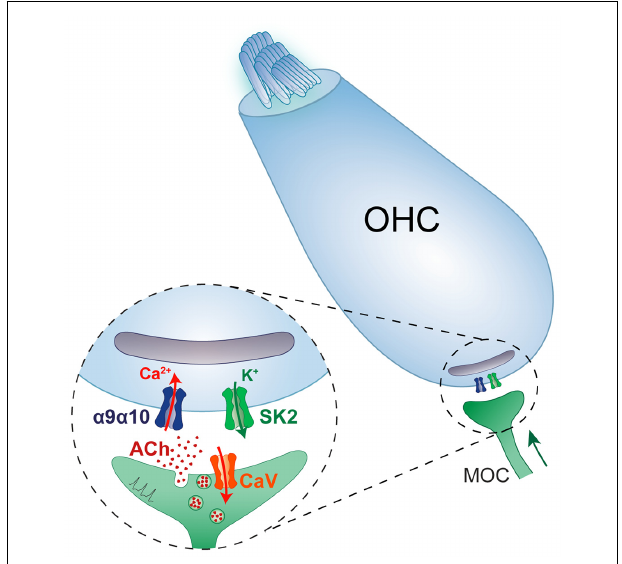
FIGURE 2 | Schematic diagram of the efferent synapse between a medial olivocochlear fibre and an outer hair cell, highlighting the different channel components involved in the ACh-triggered hyperpolarisation of hair